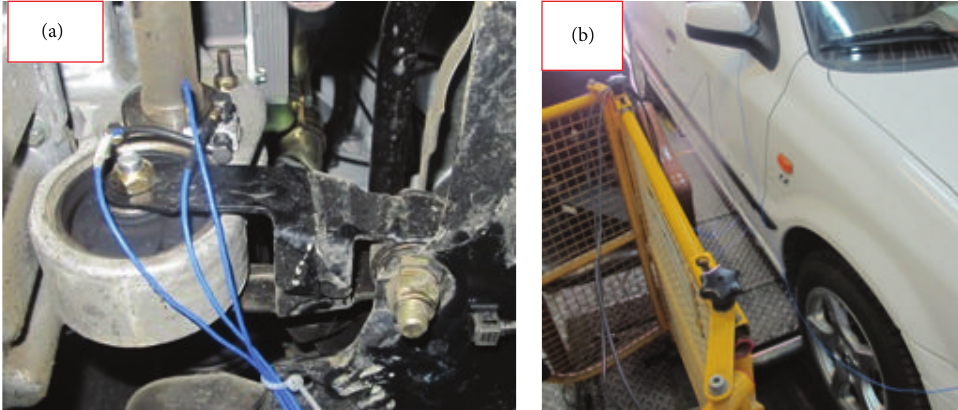
Figure 5: Test setup—(a) accelerometer installation on both sides of engine mount, (b) vehicle on chassis dyno.